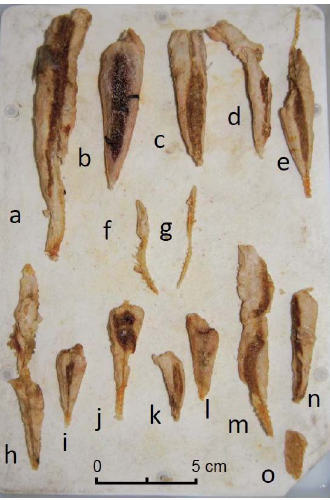
Figure 3. Stomach content of shortfin mako (individual M1, caught at zone A). At least 13 individuals of Scomberesox saurus are present (a through e and h through o); f and g, though not counted, might actually represent 2 highly digested individuals (see text). Photo Sebastia´n Bito´n.